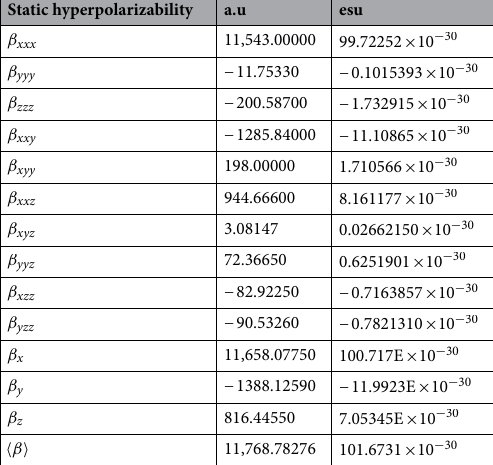
Static hyperpolarizability